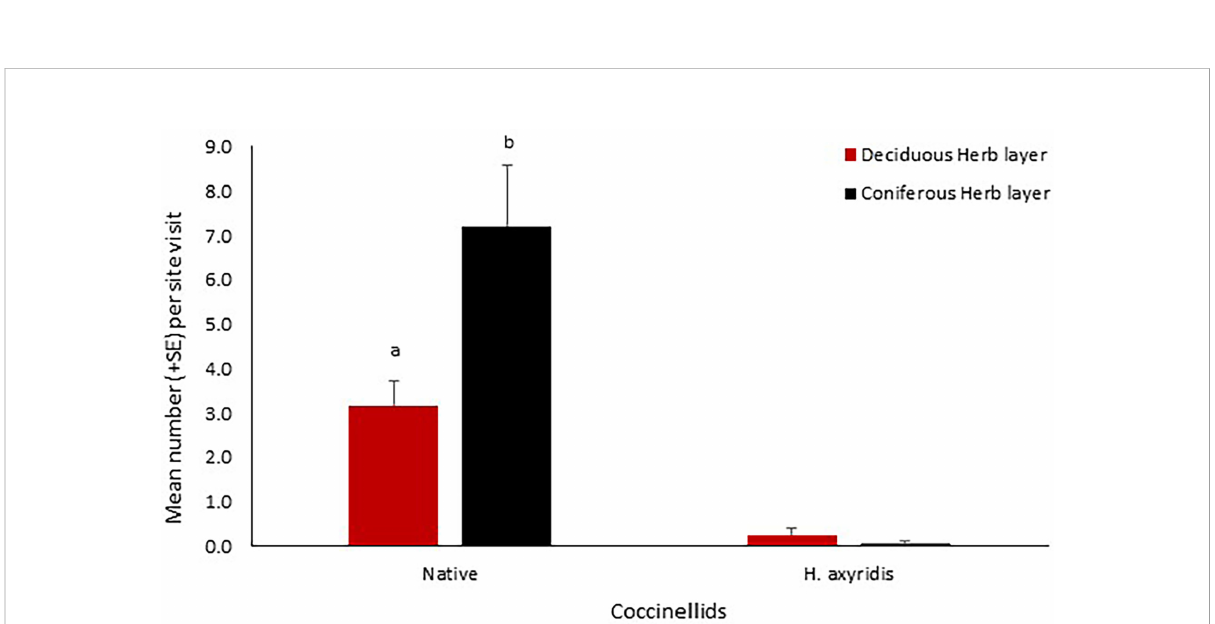
FIGURE 2 Mean number (+SE) per site visit of coccinellids recorded in the grass layer at deciduous and coniferous sites in Cambridgeshire and Suffolk. Native = all native coccinellids recorded. Consecutive letters indicate where signi fi cant differences